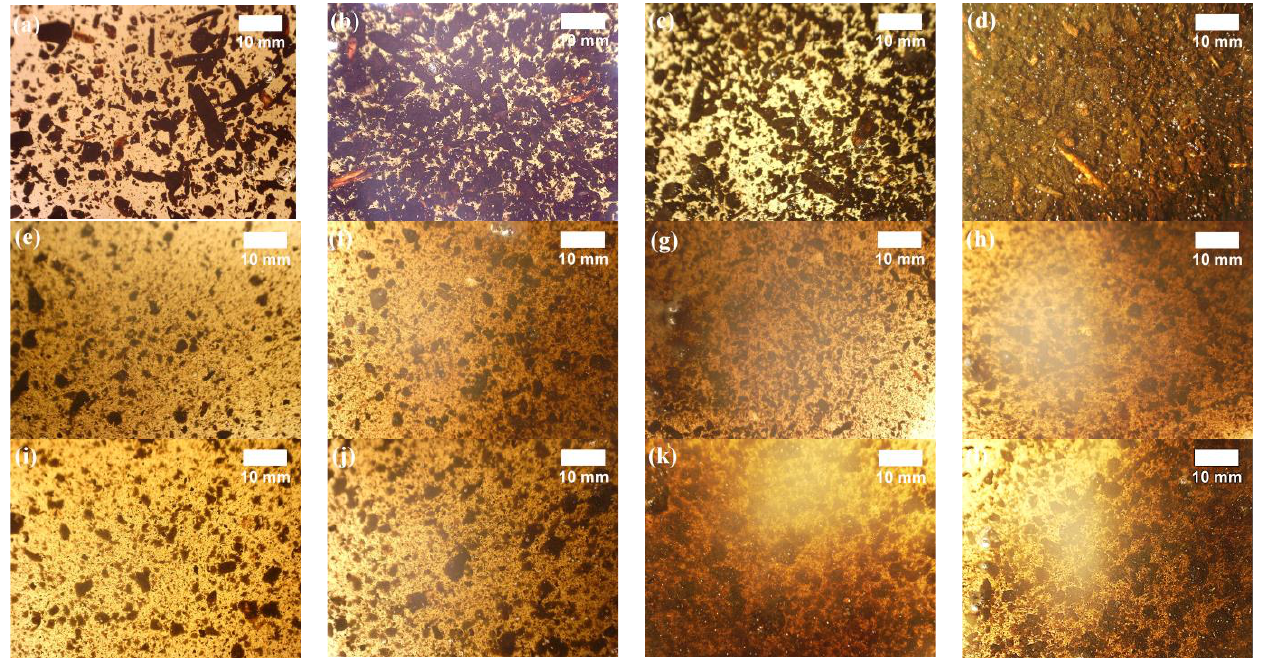
Figure 2. Particle distribution in polyol premix: ( a ) 2.5 wt.% LigW; ( b ) 5 wt.% LigW; ( c ) 7.5 wt.% LigW; ( d ) 10 wt.% LigW; ( e ) 2.5 wt.% LigW/LG 1:1; ( f ) 5 wt.% LigW/LG 1:1; ( g ) 7.5 wt.% LigW/LG